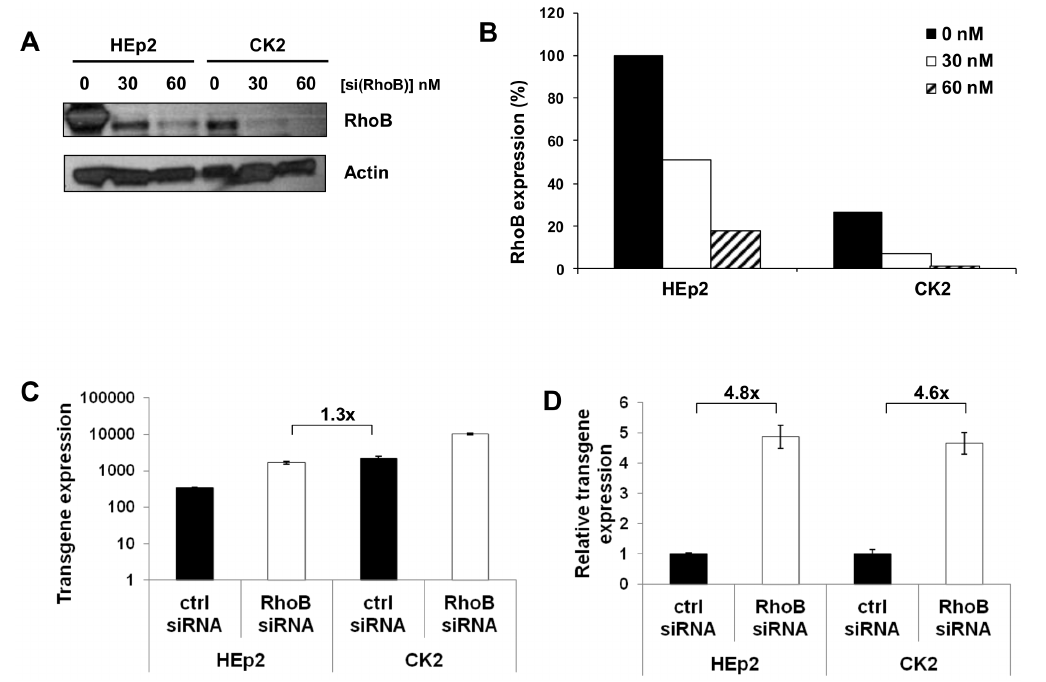
Figure 4. Decreasing RhoB expression increases Ad5wt-mediated transgene expression. HEp2 and CK2 cells were transfected with control or RhoB siRNA. Twenty-four hours after transfection cells were replated in 96-well plates for Ad5wt-mediated transgene expression measurement and 6-well plates for Western blot. Forty-eight hours after siRNA transfection, the level of RhoB was analyzed by Western blot and cells in 96-well plates were transduced for 1 hour at 37 u C with two-fold serial dilutions of Ad5wt. Twenty-four hours after infection, cells were stained for b - galactosidase expression. The transgene expression obtained with an MOI of 10 4 pp/cell is presented. (A) Forty-eight hours post-transfection the level of RhoB protein was analyzed by Western blot, i.e. at the time of Ad5wt transduction whose results are presented in C and D. Actin was used as a loading control. A representative blot of two independent experiments is presented. (B) Densitometric analysis of Western blot presented in (A). Data are presented as relative to RhoB expression in HEp2 cells that was set as 100%. (C) Ad5wt-mediated transgene expression in HEp2 and CK2 cells transfected with control or RhoB-specific siRNAs. (D). Data shown in (C) are presented as relative to control siRNA in HEp2 and CK2 cells, respectively. The results presented in (C) and (D) are representative of three independent experiments with similar results 6 standard